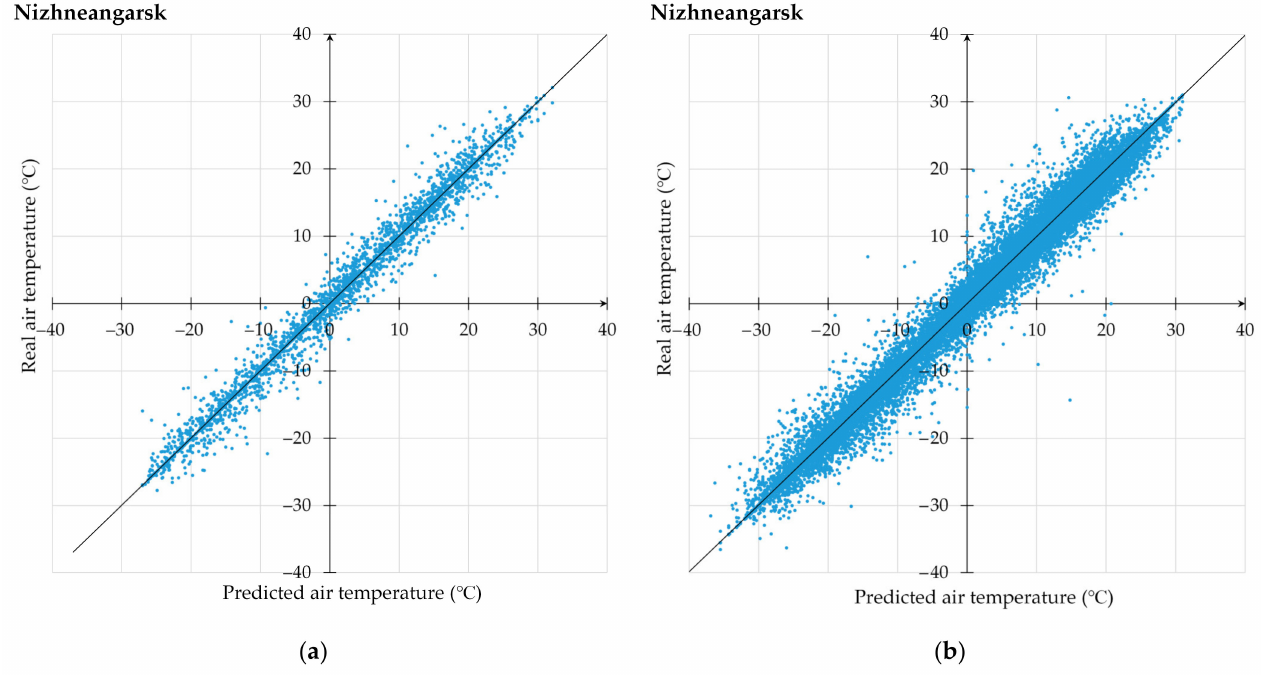
Figure 7. Prediction error scatter of (cid:101) x w